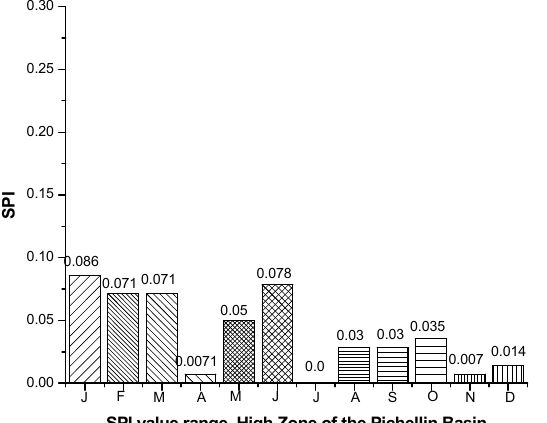
Figure 11. Standardized precipitation index (SPI), high zone.